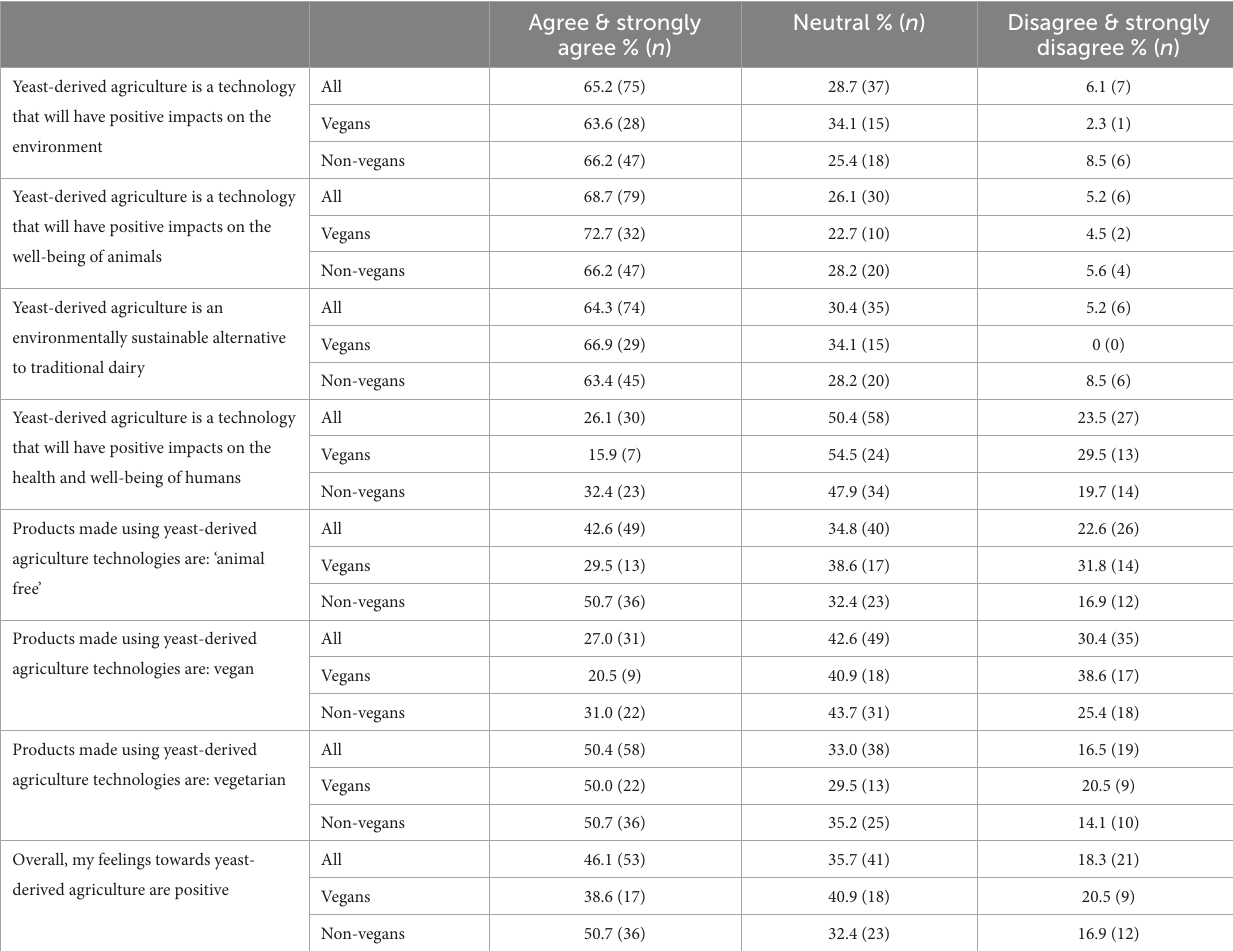
TABLE 3 Perceptions and attitudes towards yeast-derived